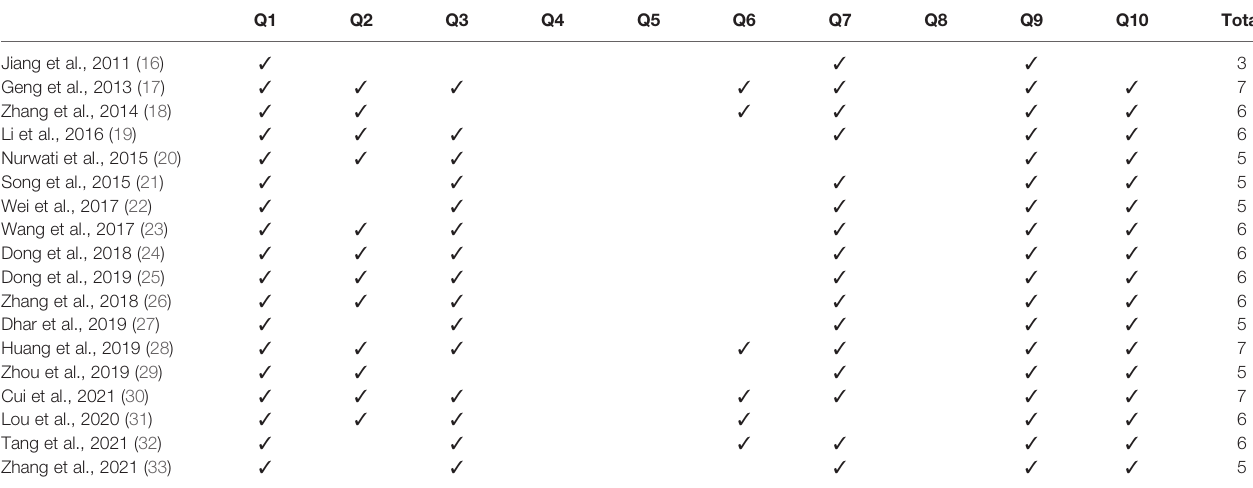
TABLE 1 | Quality